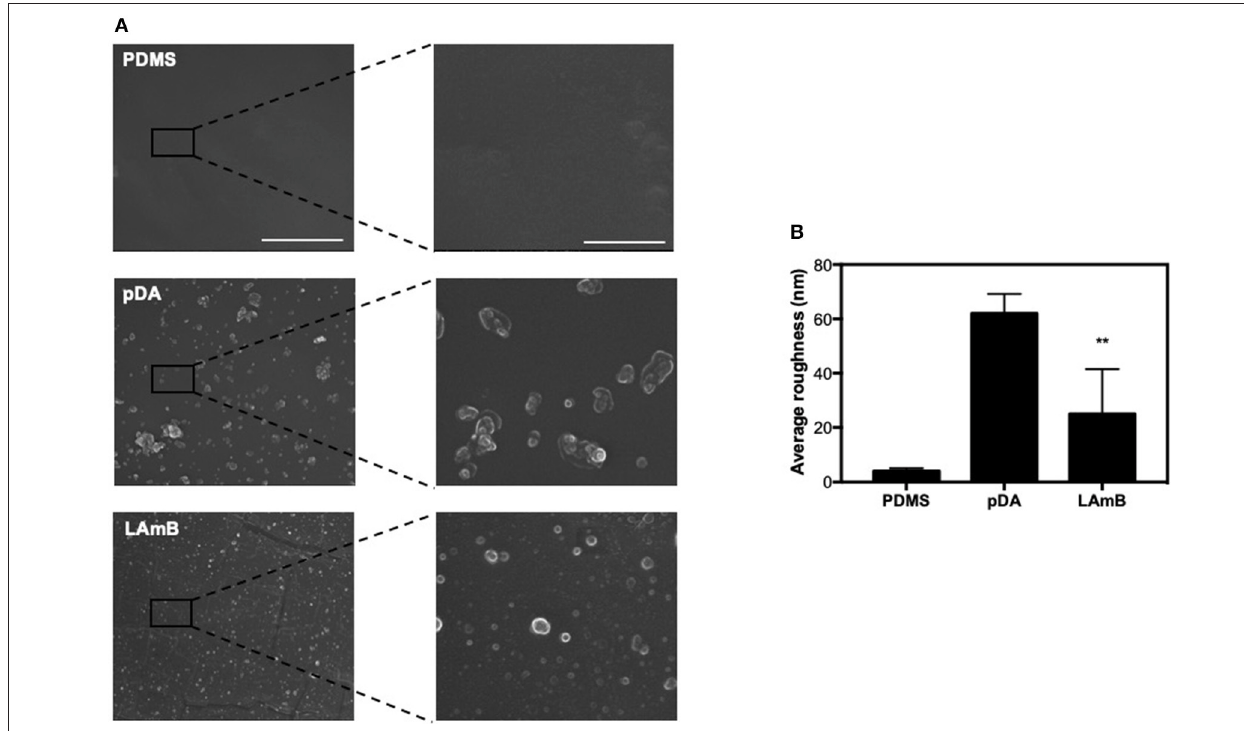
FIGURE 2 | Surface characterization. SEM images (A) and surface average roughness (B) of unmodified polydimethylsiloxane (PDMS), and pDA before and after functionalization with LAmB. The scale bars in the left and right column indicate 10 and 2 µ m, respectively. Significant differences were found for ** p < 0.01 compared to PDMS control